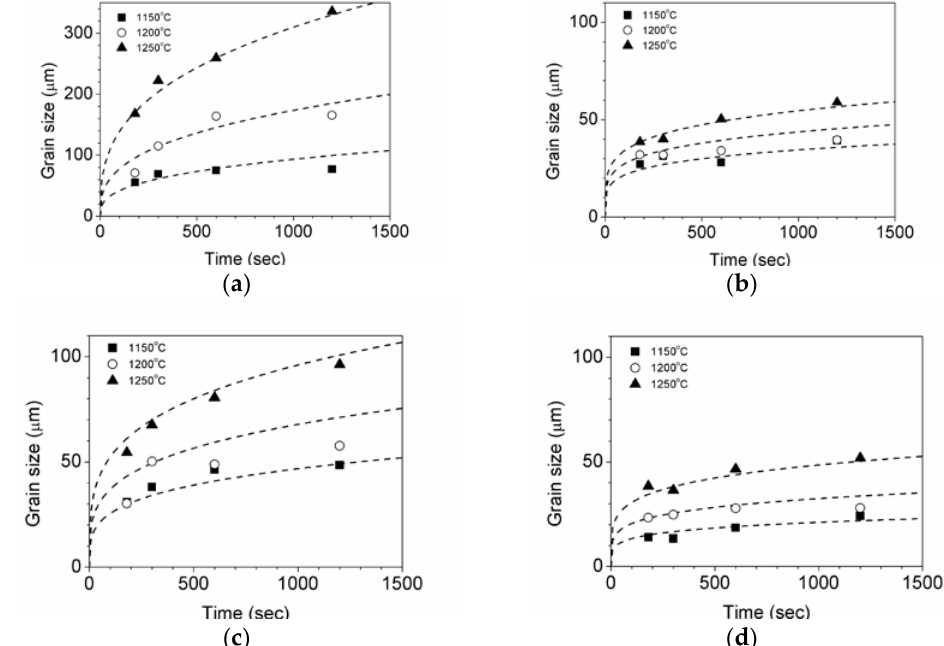
Figure 6. Grain size as a function of time for ( a ) 1.5, ( b ) 5.6, ( c ) 11, and ( d ) 22 ppm Mg, where symbols indicate experimental data and the fitting function is indicated by broken lines.